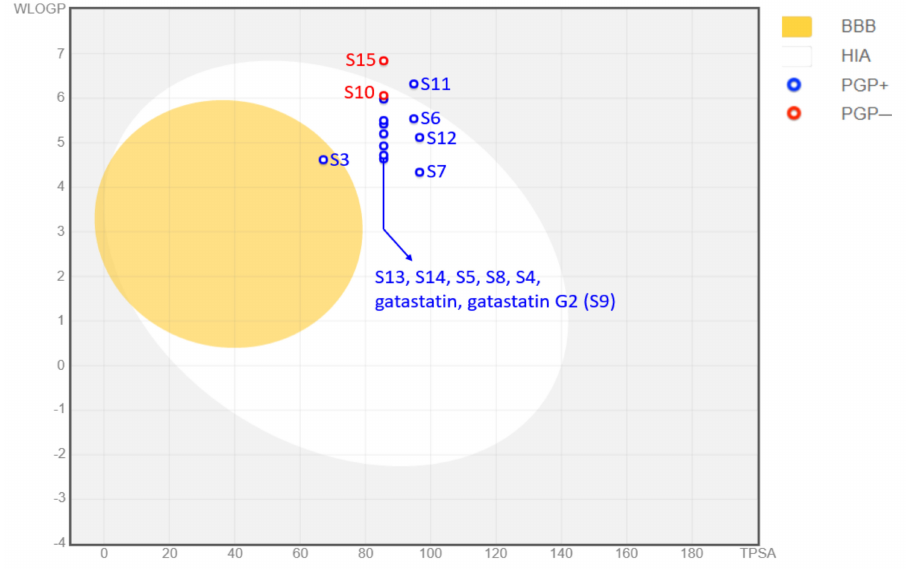
Figure 7. SwissADME Boiled–EGG summarizing results for gastrointestinal absorption, BBB perme- ation, and P-glycoprotein